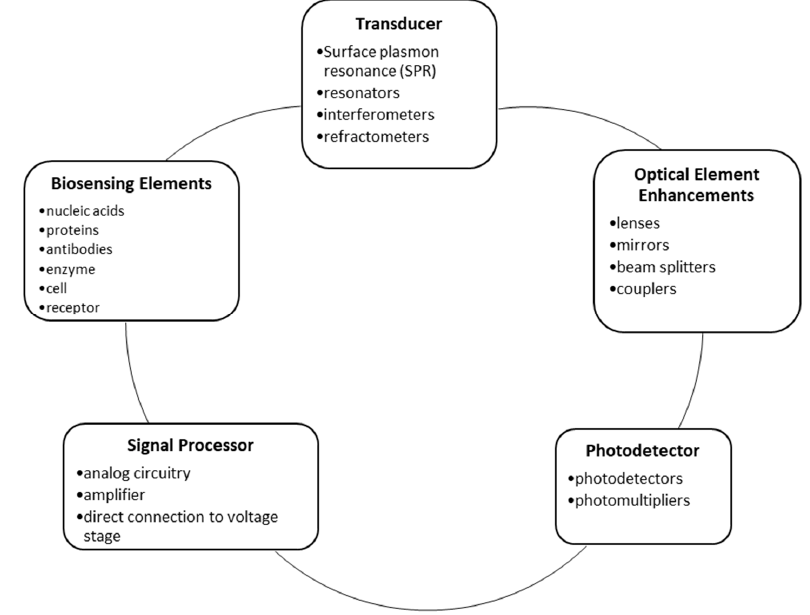
Figure 3. FOBS fundamental architecture.